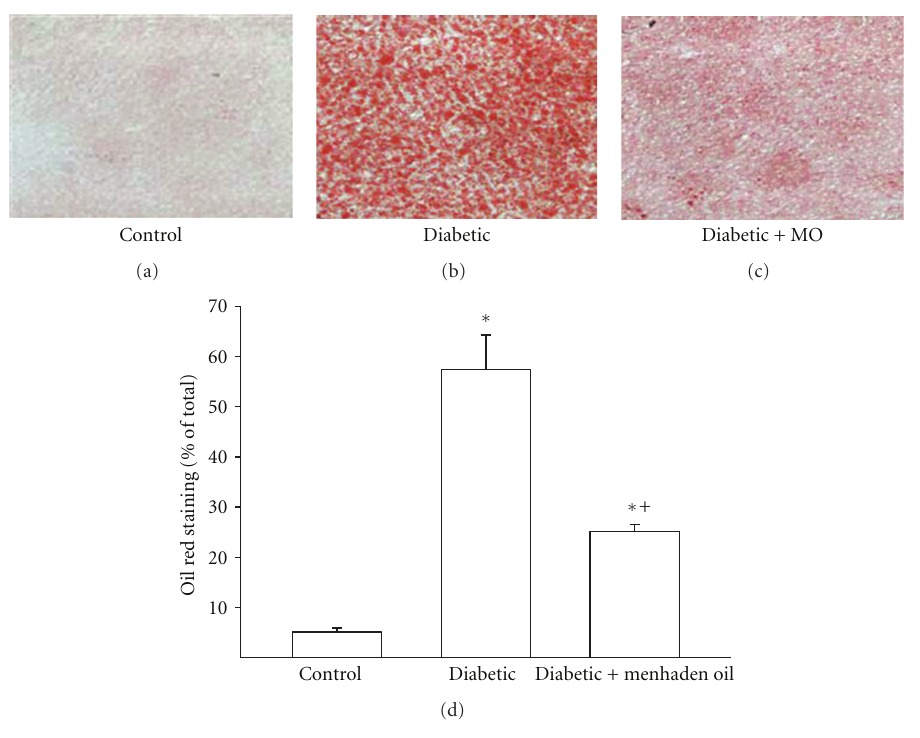
Figure 1: E ff ect of treatment of high-fat/streptozotocin diabetic rats with menhaden-oil- (MO-) supplemented diet on fatty liver disease . Fat accumulation by the liver was determined using oil red staining. Representative images are provided and data are presented as the mean ± S.E.M in % of total area. The number of rats in each group was the same as shown in Table 2. ∗ P < 0 . 05 compared to control rats; + P < 0 . 05 compared to diabetic